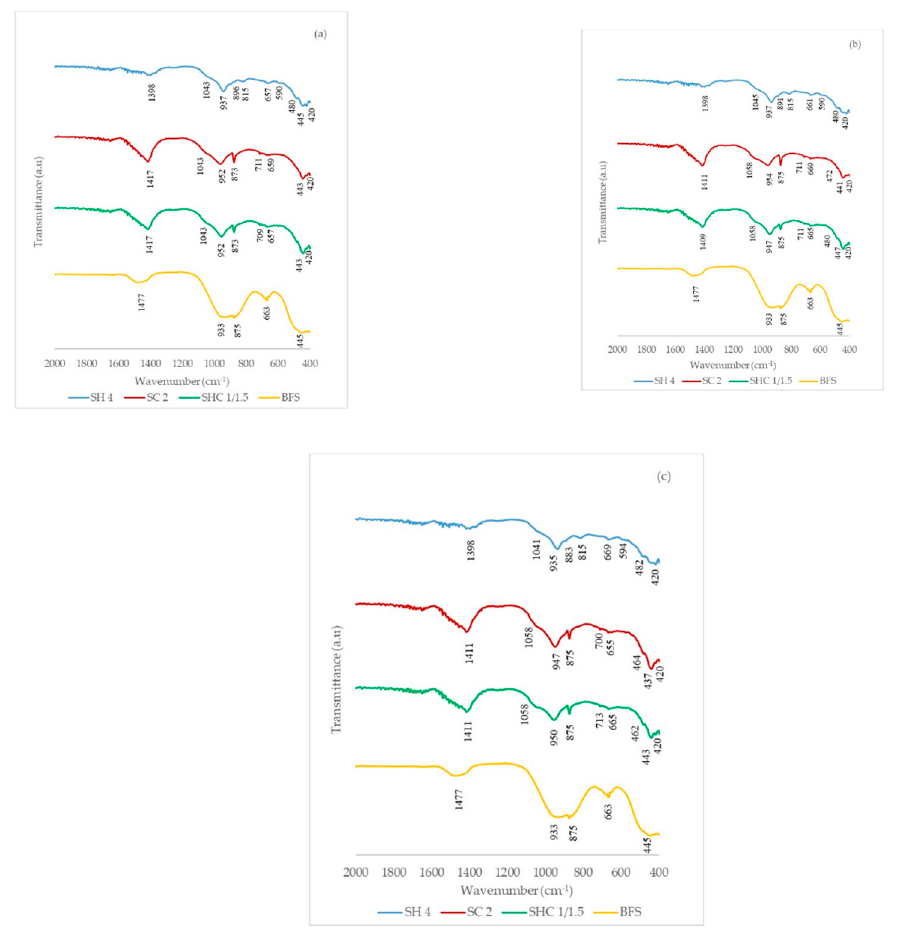
Figure 8. FTIR spectra of the pastes cured for: ( a ) 7 days; ( b ) 28 days; ( c ) 90 days. Table 4. Assignment of the bands of the FTIR